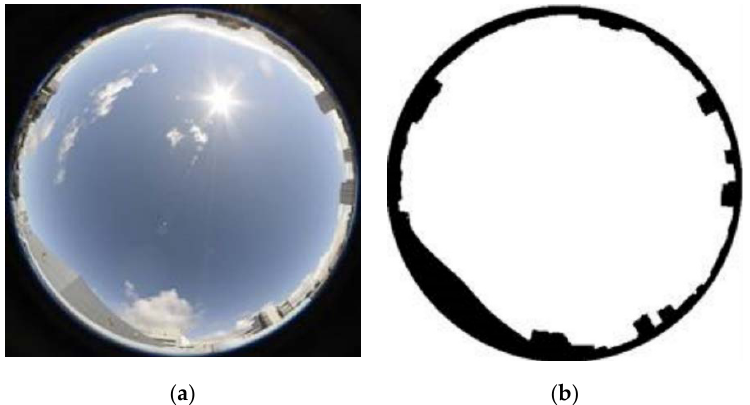
Figure 6. ( a ) EA building of Glasgow Caledonian University (GCU) (N 55°51 ′ 57.71 ″ , W 4°15 ′ 00.49 ″ ) and ( b ) SVF =